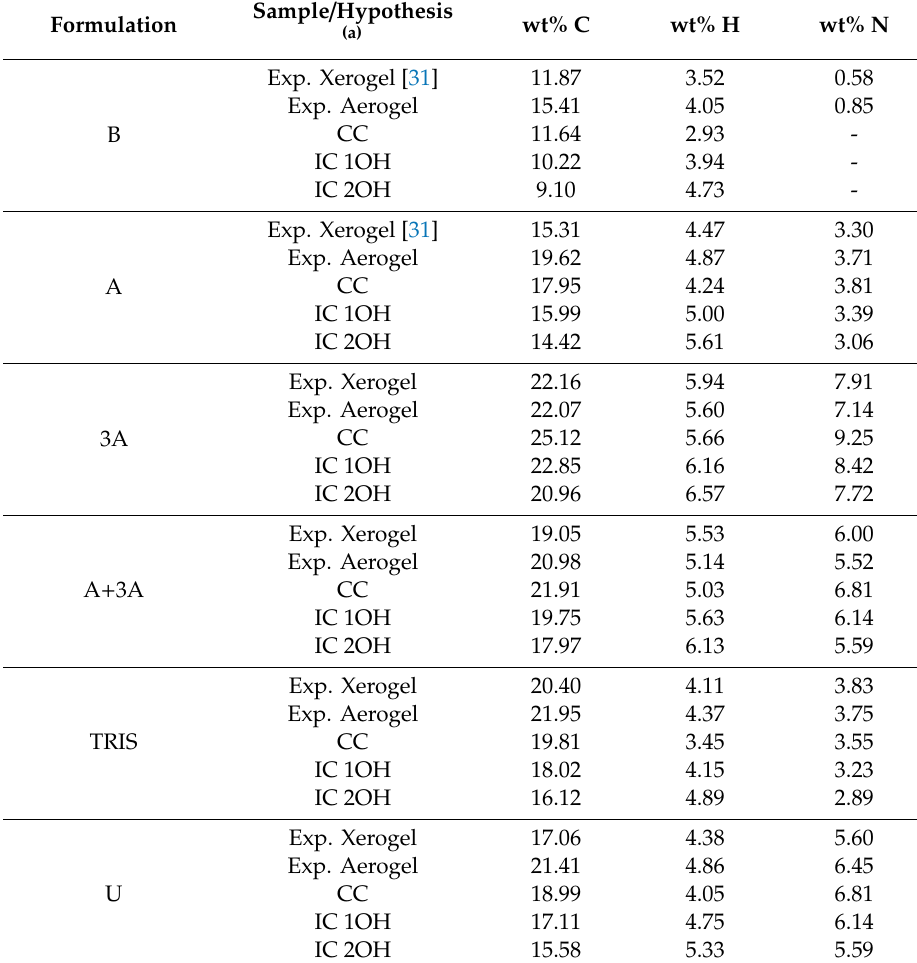
Table 3. Chemical composition of the studied